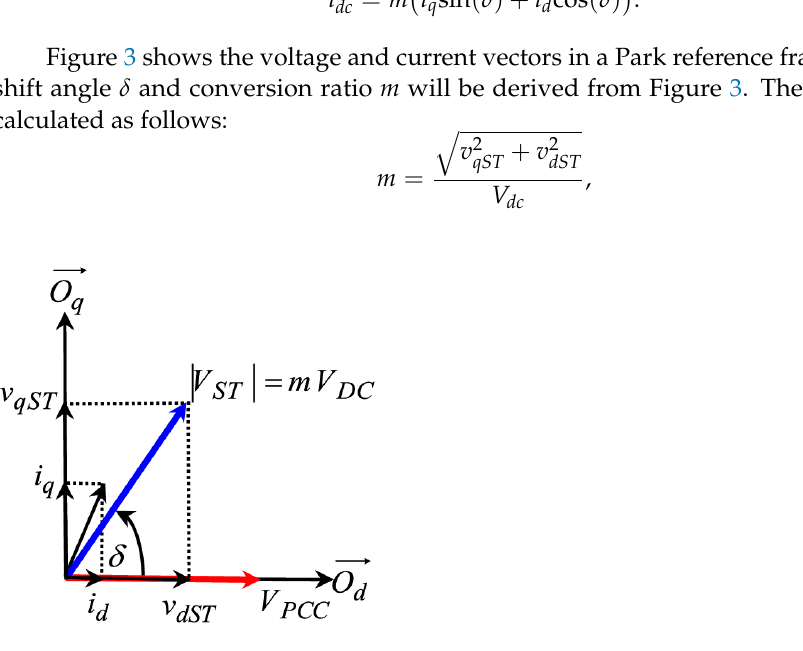
Figure 3. Vector diagram of D-STATCOM voltages and currents.